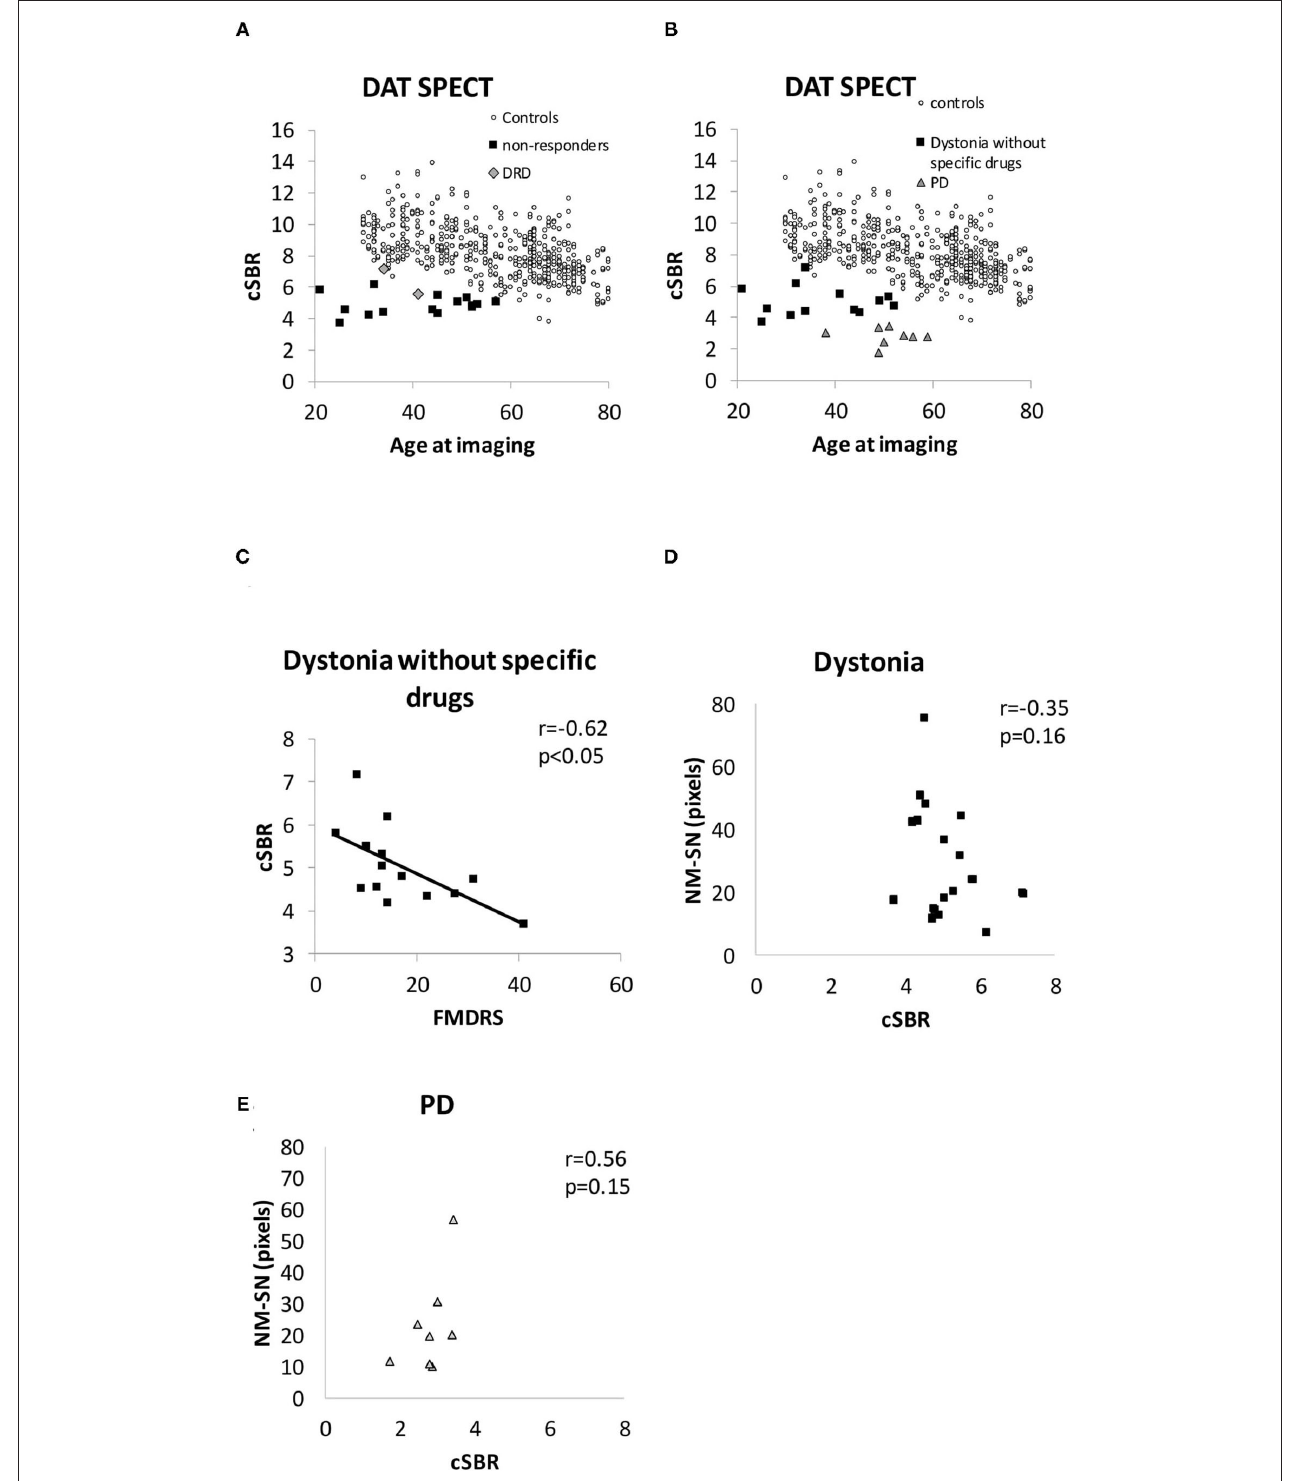
FIGURE 5 | (A) Distribution of the cSBR in patients with DRD and non-responders. (B) Distribution of the cSBR in patients with dystonia, not taking specific drugs influencing the results of DAT SPECT. (C) Correlation between the FMDRS and the cSBR obtained from patients with dystonia not receiving specific drugs. (D) Comparison between the cSBR and the NM-SN area in patients with dystonia. (E) Comparison between the cSBR and the NM-SN area in patients with PD. cSBR, calibrated specific binding ratio; DAT SPECT, dopamine transporter single-photon emission computed tomography; DRD, dopa-responsive dystonia; NM-SN, neuromelanin-substantia nigra; PD, Parkinson’s disease; SEM, standard error of the mean.